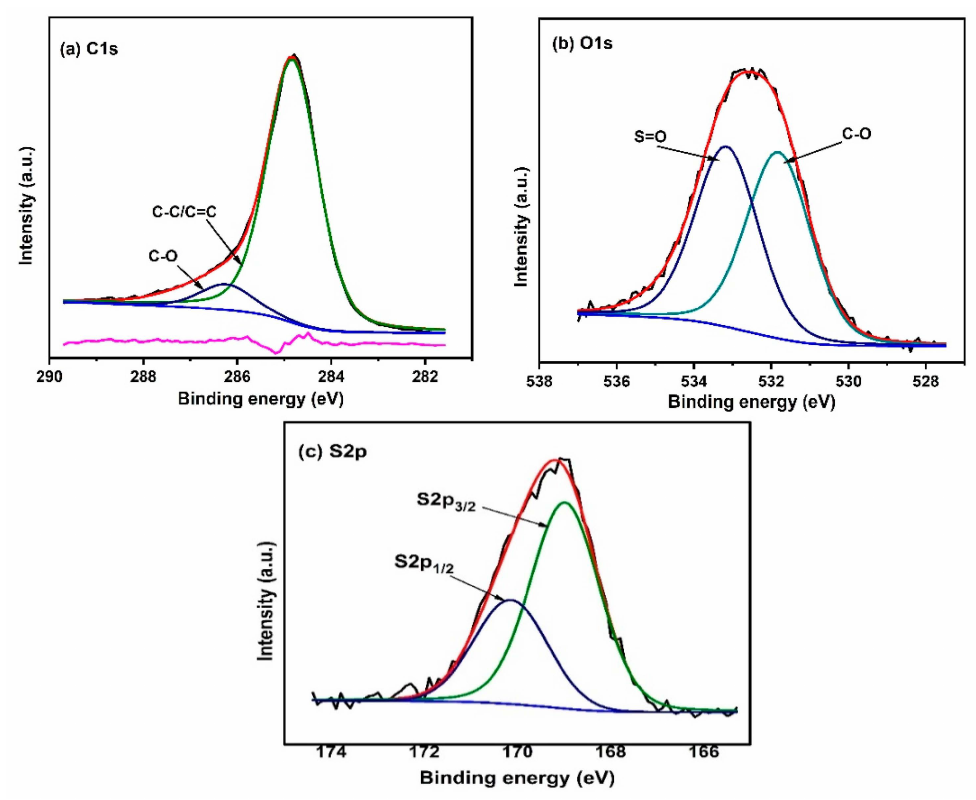
Figure 5. XPS spectra of ( a ) C 1s, ( b ) O 1s, and ( c ) S 2p of the OMSC catalyst.